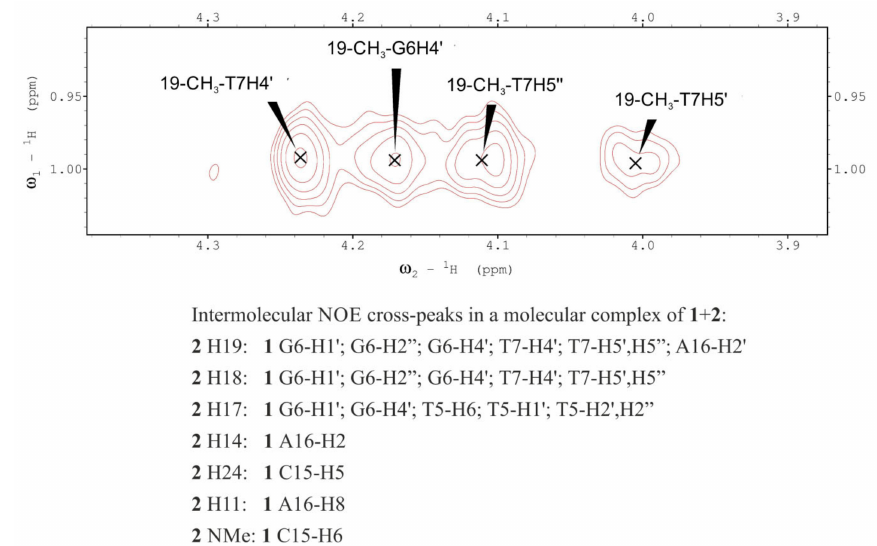
Figure 1. The list of NOE cross-peaks found for molecular complex 1 + 2 and the part of the NOESY spectrum representing the intermolecular cross-peaks between 19-CH 3 group in 2 and DNA bases in the nick of 1 (Figures S8 and S8a). For the NOESY and intermolecular cross-peaks in a complex 1 + 3 , see Figures S9 and S10.